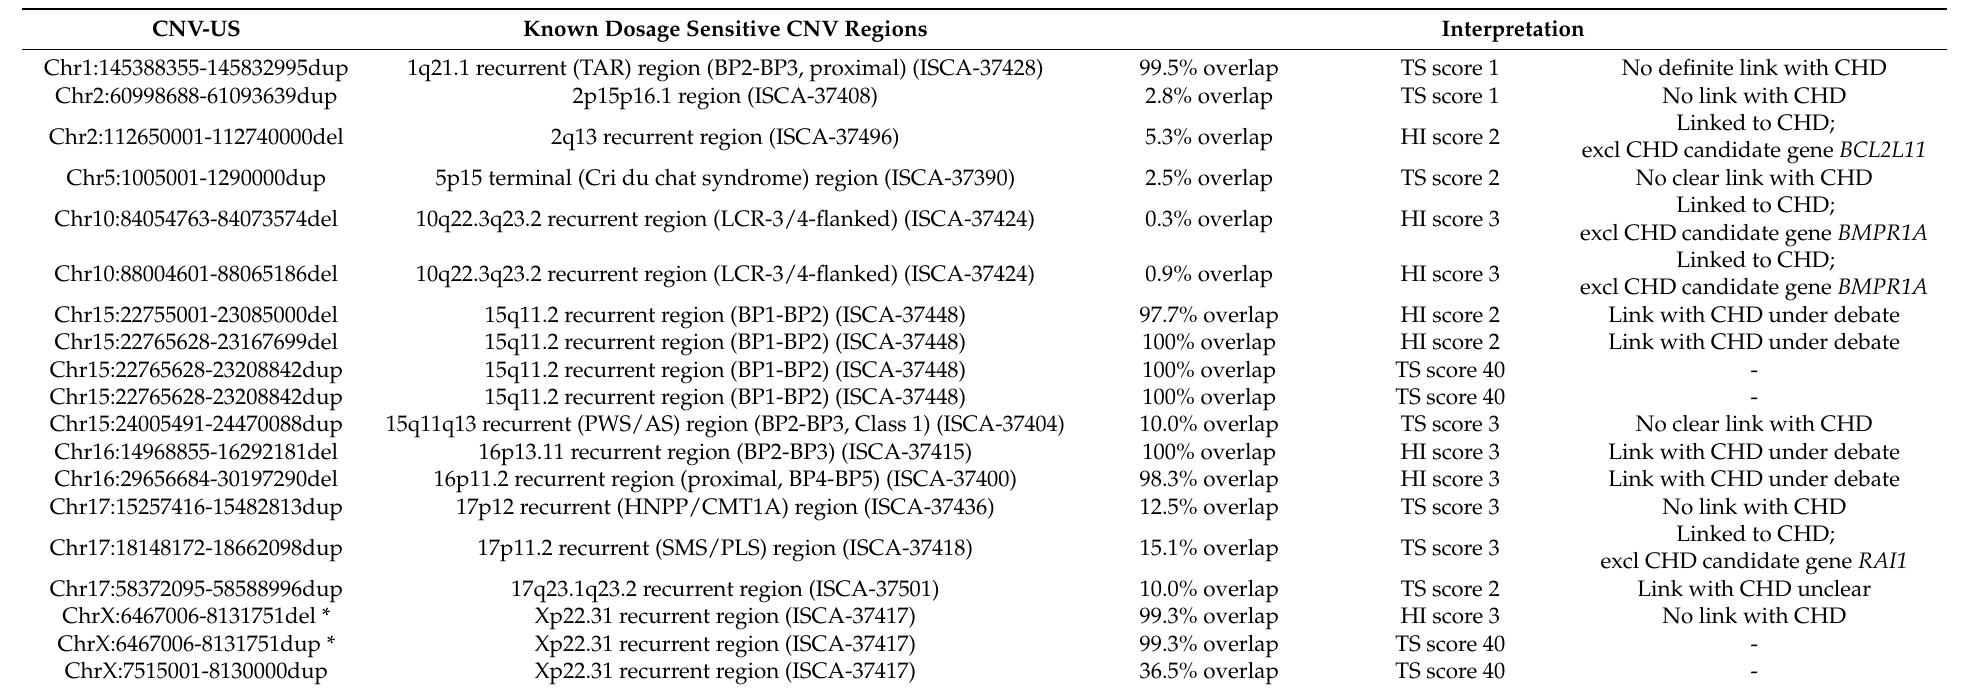
Table 1. Overlap of CNV-US with known ClinGen Pathogenic or Dosage Sensitive CNV